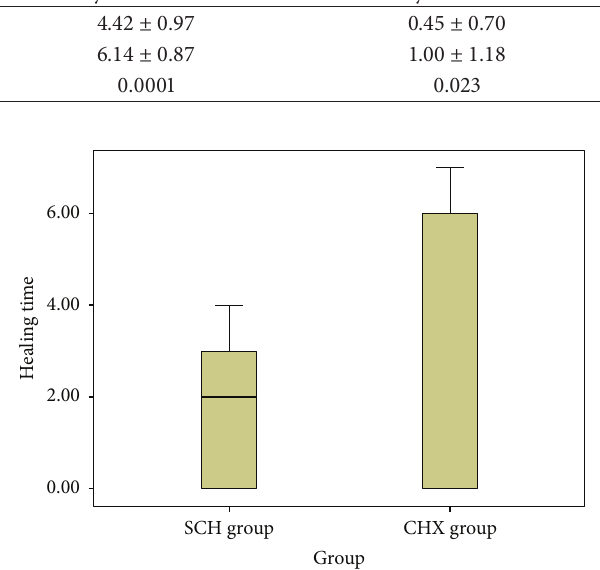
Figure 1: The mean healing time in ulcers in SCH group and CHX